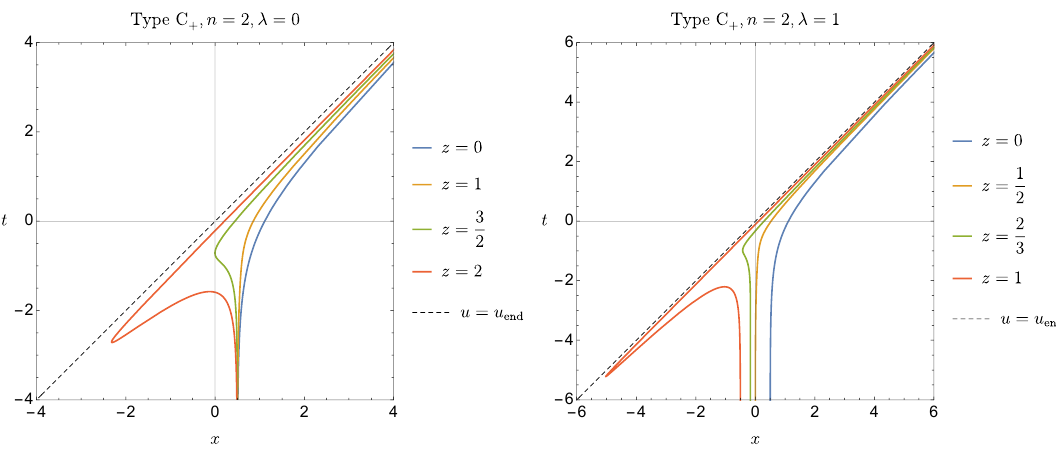
Figure 15 . The profiles of brane Q associated with moving mirrors of type C + . The mapping functions are defined in eq. (4.5). We have chosen β = 1 , u